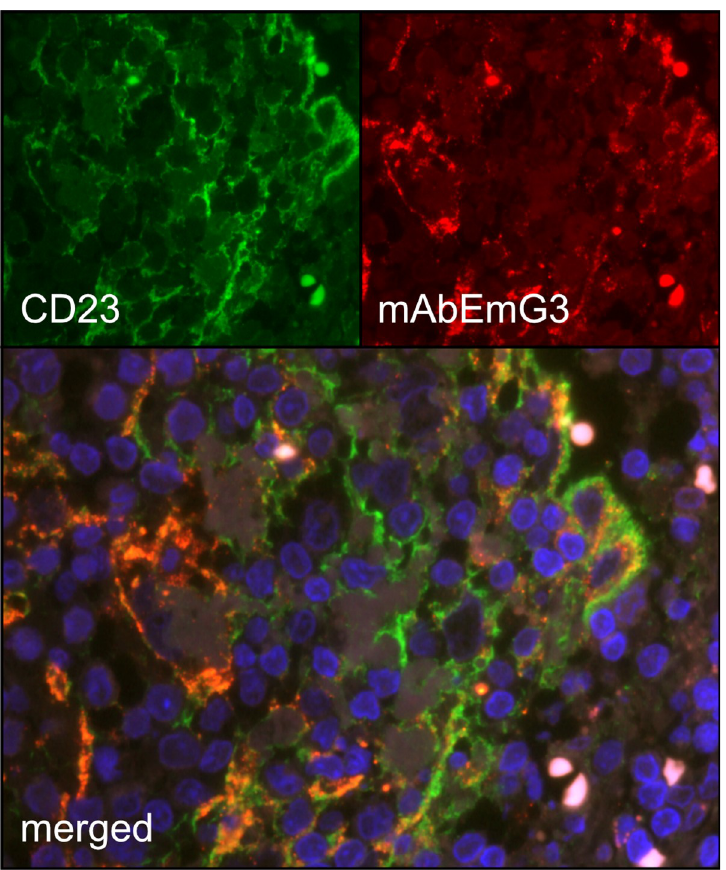
Fig 4. Fluorescence staining of lymph node containing spegs from patients with cystic echinococcosis. Double- immunofluorescence staining with CD23 (A; green) and mAb EmG3 (B; red) of a lymph node tissue of a patient with CE. The two antigens are co-located (C; merged,